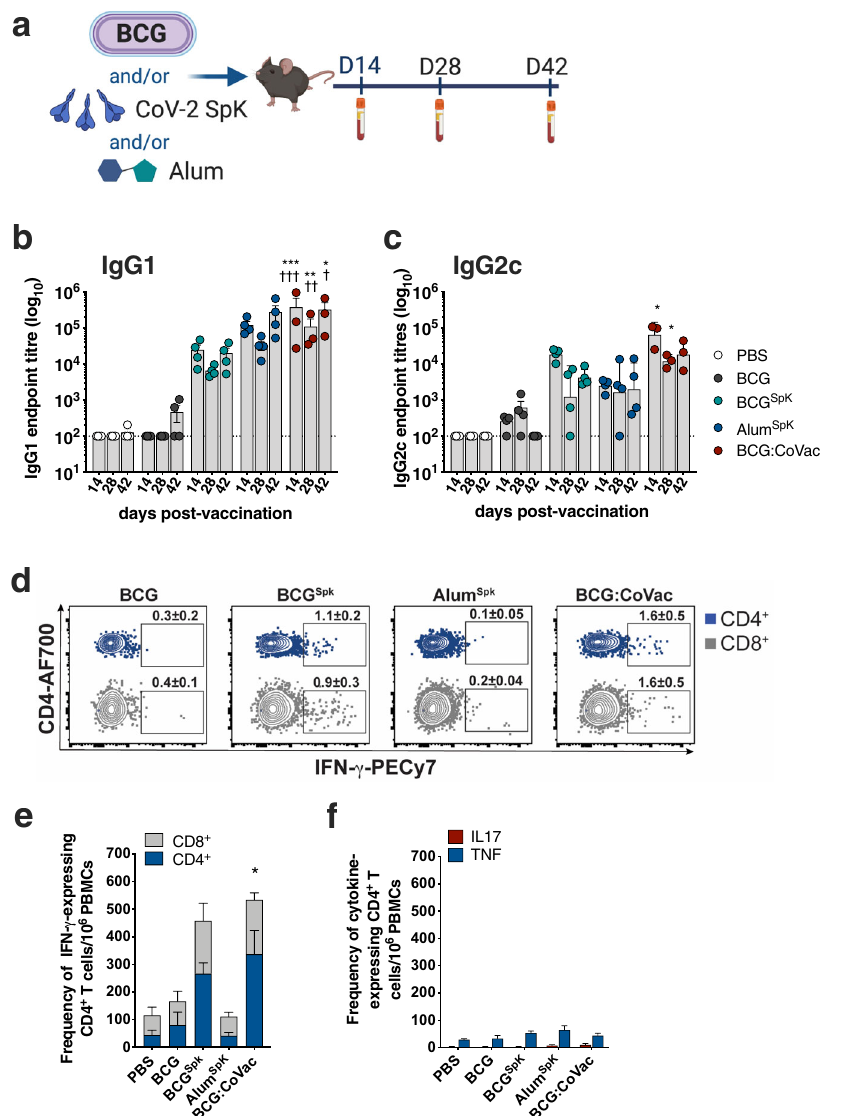
Fig. 1 Single immunisation with BCG:CoVac vaccine induces rapid development of anti-SARS-CoV-2 spike antibodies and IFN- γ -secreting T cells. a C57BL/6 mice ( n = 4/group) were vaccinated subcutaneously with PBS, BCG, BCG SpK , Alum SpK or BCG:CoVac and whole blood collected at day 14, 28 and 42. b , c Spike-speci fi c IgG1 and IgG2c titres in plasma were determined by ELISA and estimated by the sigmoidal curve of each sample interpolated with the threshold of the negative sample ±3 standard deviations. The dotted line shows the limit of detection. d At 14 days post-vaccination PBMCs were restimulated ex vivo with 5 μ g/mL of SARS-CoV-2 spike and cytokine production determined by fl ow cytometry. Representative dot plots of CD44 + CD4 + T cells and CD44 + CD8 + T cells expressing IFN- γ with average ± SEM (gating strategy in Supplementary Fig. 3). e Frequency of circulating CD4 + and CD8 + T cells expressing IFN- γ or f CD4 + T cells expressing IL-17 or TNF per 10 6 PBMCs. Data presented as mean ± SEM and is representative of two independent experiments. Signi fi cant differences between groups compared to BCG Spk * p < 0.05, ** p < 0.01, *** p < 0.01 or Alum Spk † p < 0.05, †† p < 0.01, ††† p < 0.001 were determined using one- way BCG:CoVac-primed mice boosted with Alum SpK (Fig. 5c). Boosting Alum SpK vaccination with a second dose led to a greater than 10- fold increase in NAbs in boosted mice; however, responses were signi fi cantly higher in those with the BCG:CoVac-prime, Alum SpK-- boost combination (Fig. 5c). Plasma from BCG:CoVac-vaccinated mice was able to neutralise both the B.1.1.7 variant (1.3-fold decrease compared to wild-type virus) and B.1.351 variant (2.7- fold decrease) (Fig. 5d). Neutralisation capacity against B.1.1.7 and B.1.351 was maintained to some extent after prime-boost with Alum SpK only, however titres were approximately 10-fold less than those following the BCG:CoVac prime, Alum SpK combination (Fig. 5e).